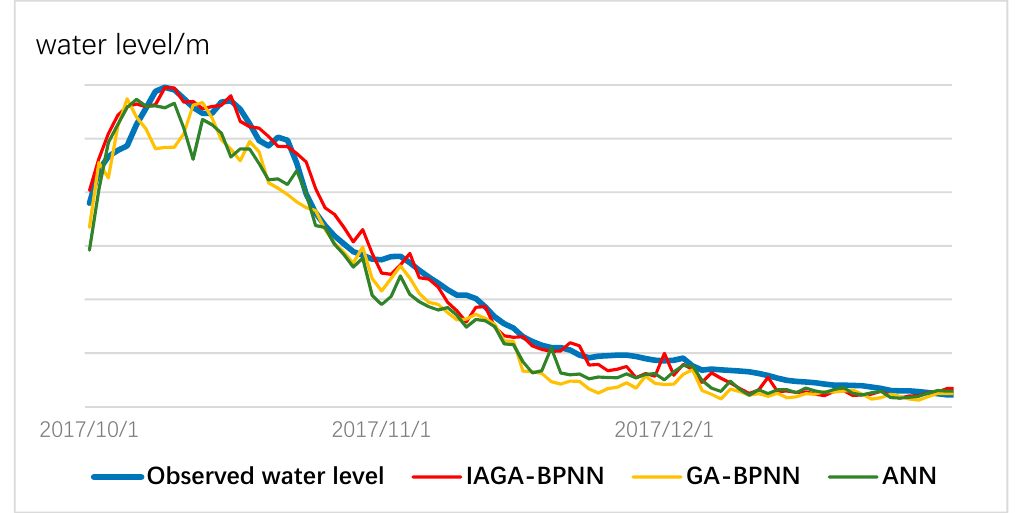
Figure 11. Comparison results for the three models for water-level prediction from October to December 2017.